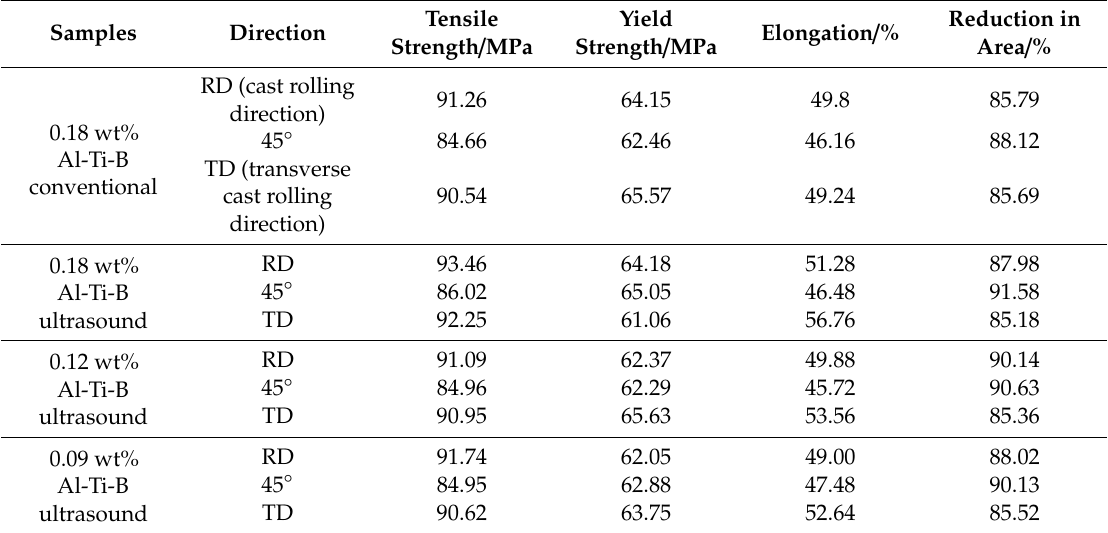
Table 2. Mechanical properties of the 1060 aluminum alloy cast rolling strips with di ff erent treatments.